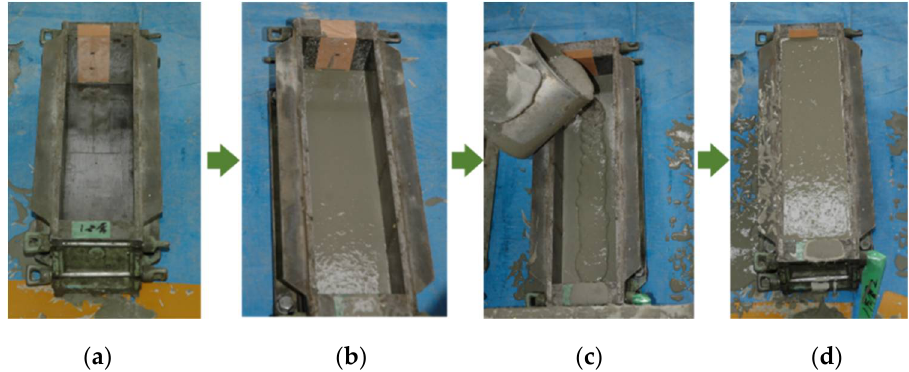
Figure 2. Fabrication of specimen: ( a ) mold before casting; ( b ) after pouring the first layer; ( c ) pouring the second layer 60 min after the first layer pouring; ( d ) after pouring the third layer.